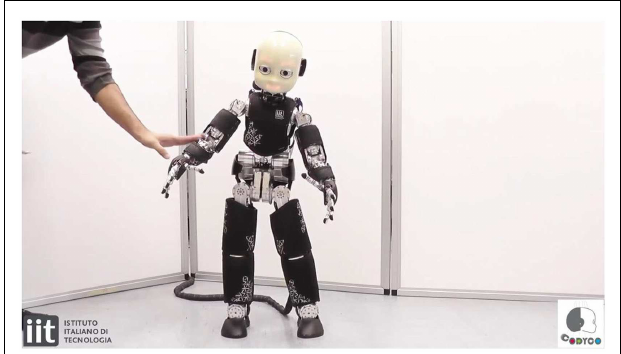
FIGURE 1 | See the video showing the control performances of the control architecture